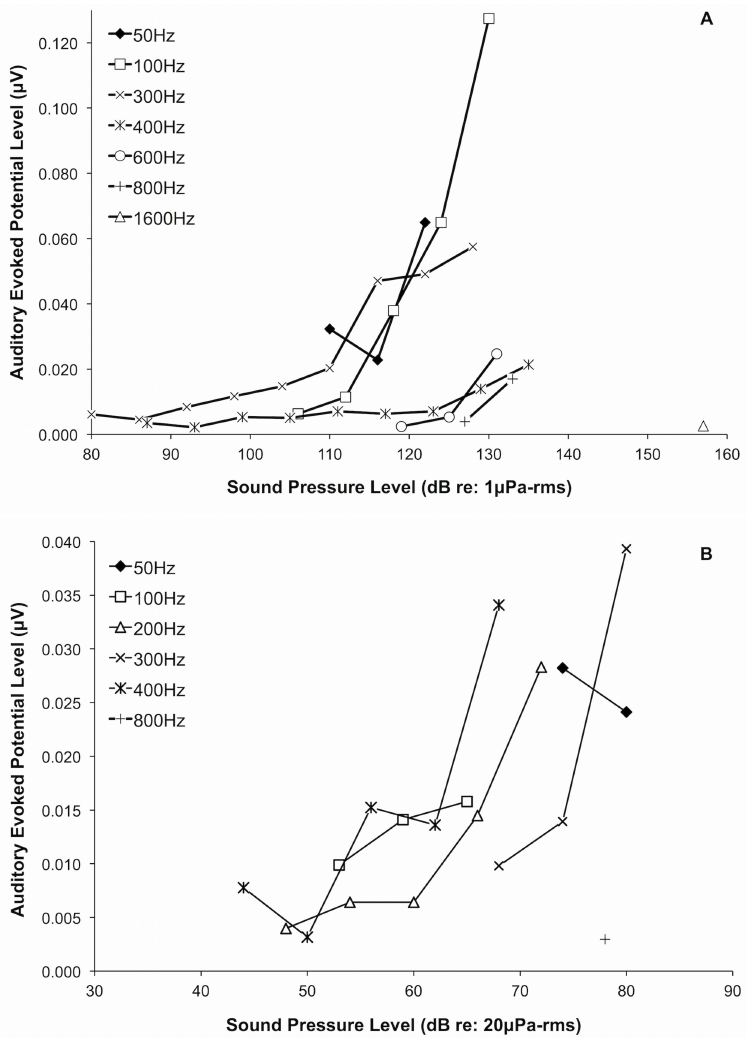
Fig 3. Juvenile green sea turtle ( Chelonia mydas , L4) underwater (A) and aerial (B) input-output functions of auditory evoked potential level ( μ V) as a function of stimulus sound pressure